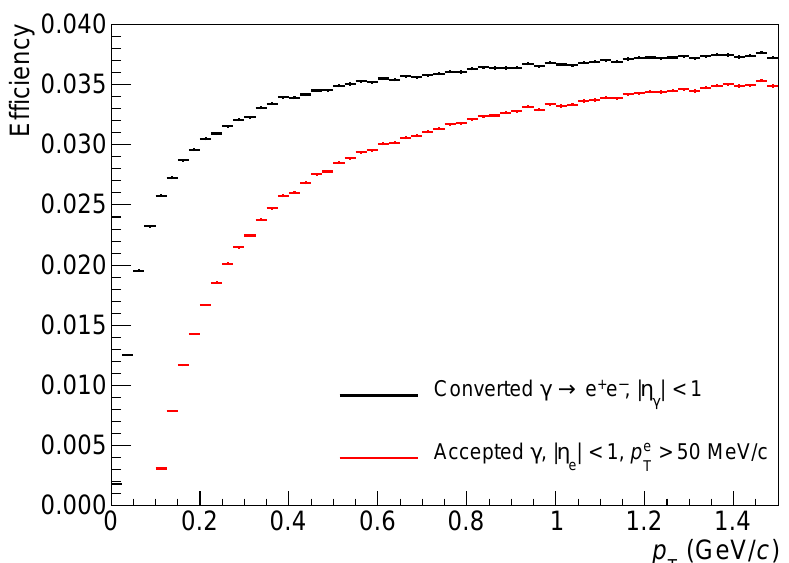
Figure 1. Photon conversion probability (black) and acceptance (red) as a function of the photon transverse momentum.